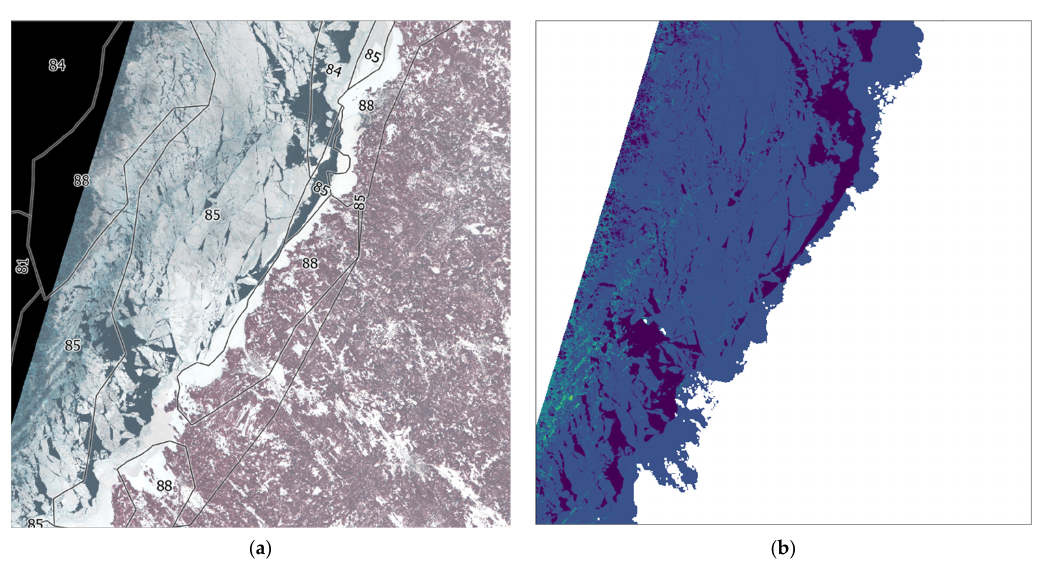
Figure 17. ( a ) Landsat-8 false color for 16 February 2021; BSH ice chart for 16 February 2021; ( b ) ICESOD classification.